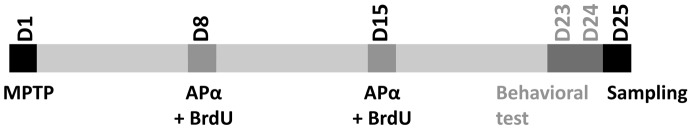
Experimental Design.Nine weeks old C57BL/6 male mice were randomly divided into 4 groups (SV, saline+vehicle; SA, saline+APα; MV, MPTP+vehicle; MA, MPTP+APα; 12–13/group). The mice were injected with MPTP (20 mg/kg)/2 h×4) or saline on day 1 (D1). The first APα (10 mg/kg of BW) and BrdU (100 mg/kg of body weight) injections were performed on day 8 (D8) and the second APα and BrdU injections were done on day 15 (D15) after MPTP injection. Seven mice of each group underwent behavioral tests on day 23 (D23) and day 24 (D24). The brain samples were collected on day 25 (D25) after MPTP injection for immunohistochemical and biochemical analyses.